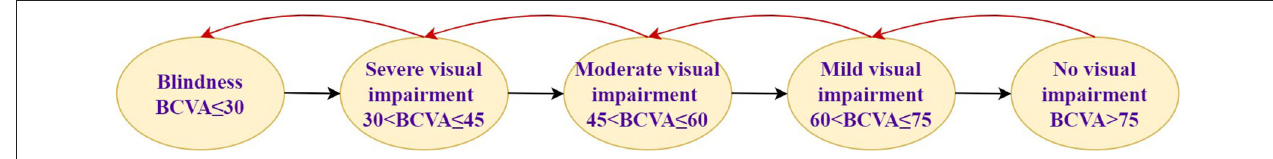
FIGURE 2 | The Markov model structure of diabetic macular edema.